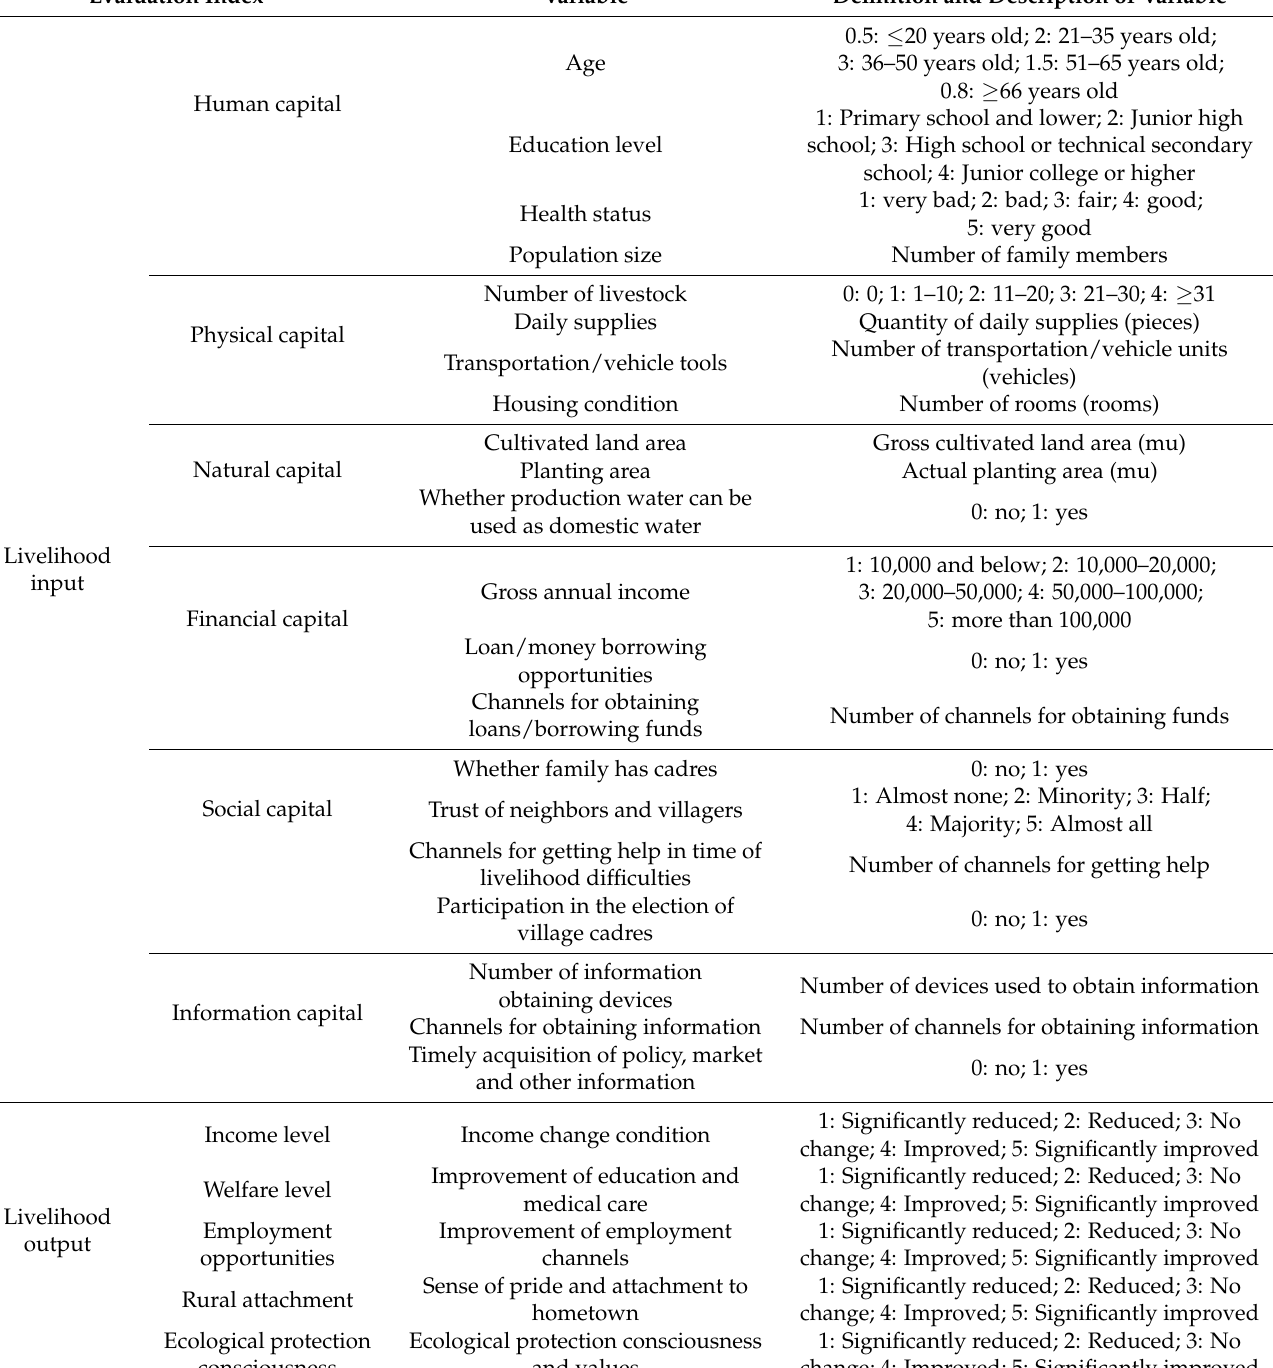
Table 2. The evaluation index system of household livelihood